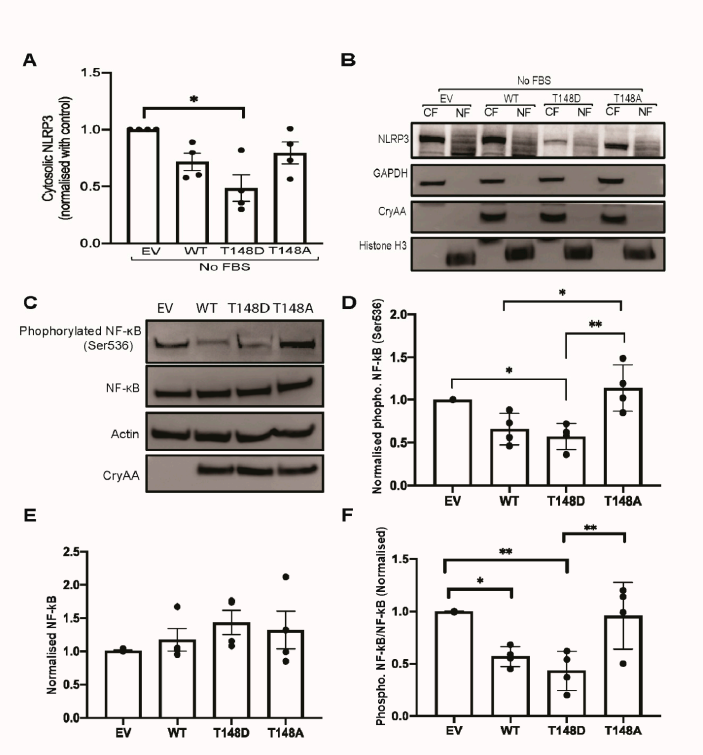
Figure 5. HspB4/ α A-crystallin regulates neuro-inflammation in MGCs by inhibiting NLRP3 in- duction and NF-kB activation. Primary Müller cells (HspB4 − / − ) were transfected with either empty vector (EV), wild-type HspB4/ α A-crystallin (WT), phosphomimetic form of HspB4/ α A- crystallin (T148D), or non-phosphorylatable form of HspB4/ α A-crystallin (T148A). Then, 24 h post transfection, cells were exposed to either serum starvation (no FBS) or diabetic-like stress (25 mM glucose + 100 ng/mL TNF α ) for 4 h. For the inflammasome, NLRP3 subcellular localization was assessed in cytosolic and nuclear fractions and normalized to the empty vector ( A ). Repre- sentative images of immunoblot signal for NLRP3, HspB4/ α A-crystallin as well as GAPDH and histone-H3, which served as the cytosolic (CF) and nuclear fraction (NF) controls, respectively ( B ). For NF-kB activation, total lysate levels were analyzed for total and phosphorylated NF-kB (Ser536), HspB4/ α A-crystallin, and actin, the latter being used as loading control (representative images in ( C ). Fold change of phosphorylated NF-kB (Ser536) ( D ), total NF-kB ( E ), and ratio of phosphorylated NF-kB (Ser536) to total NF-kB ( F ) are shown normalized to the empty vector. * p ≤ 0.05, ** p ≤ 0.01, significantly different from the respective EV-transfected cells. The primary Müller cells (HspB4 − / − ) were used up to passage 4 for the experiments. Each endpoint was measured on a minimum of three technical replicates. Statistical analysis was performed by one-way ANOVA followed by Student–Newman–Keuls